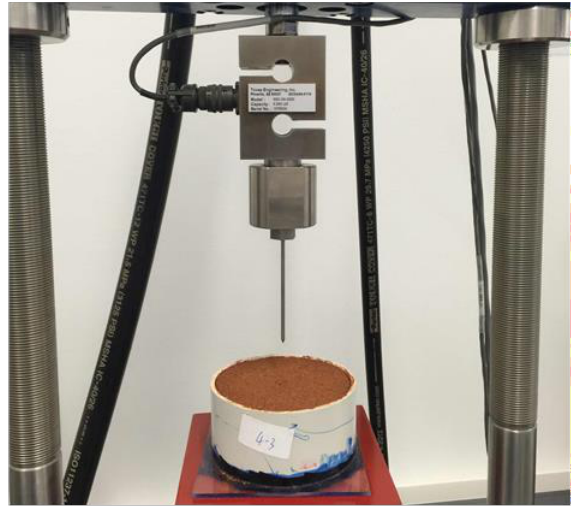
Figure 4. Penetration resistance test apparatus.